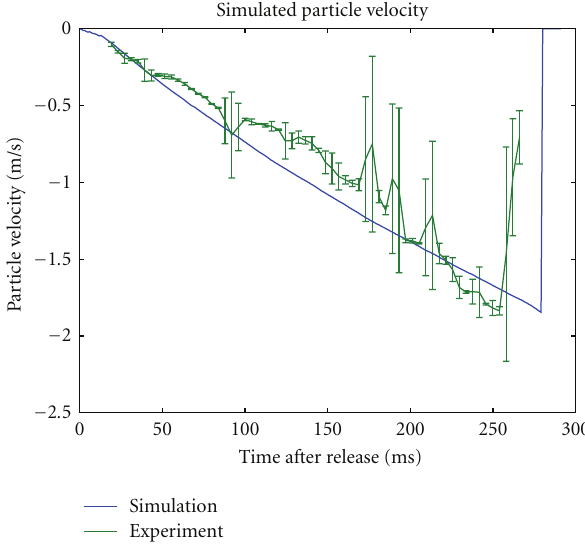
Figure 6: Glass sphere velocity measured at 22 mm above the bot- tom of the tube as a function of